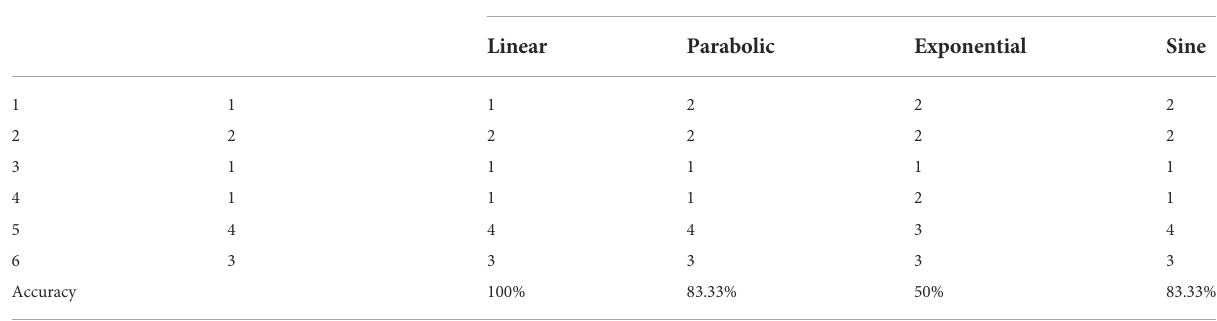
TABLE 6 Evaluation results of unascertained measurement ( GP I ).